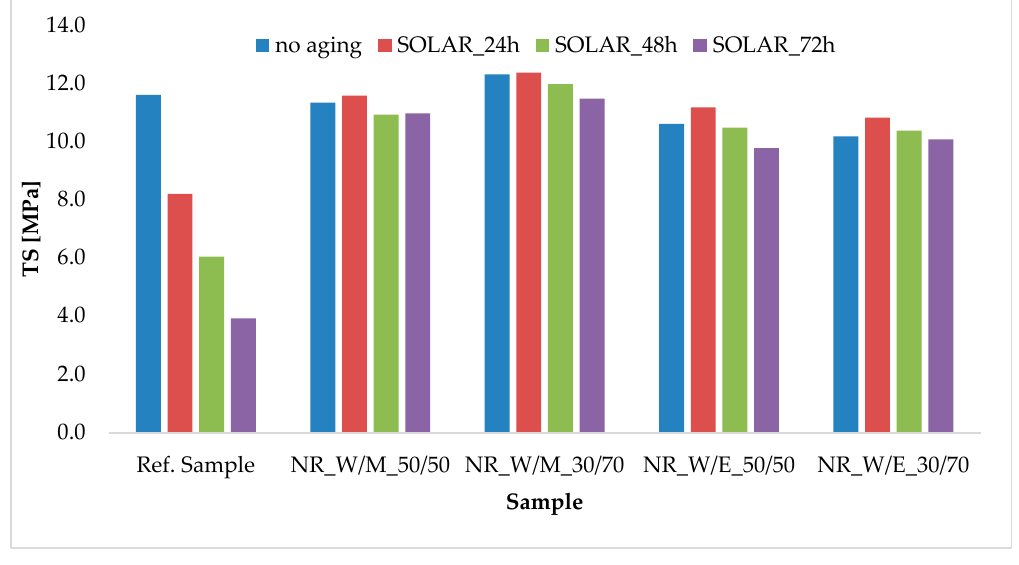
Figure 7. Tensile strengths of vulcanizates before and after the simulated SOLAR aging process. Table 8. Elongation at break of vulcanizates before and after simulated SOLAR aging process and aging factor (K).